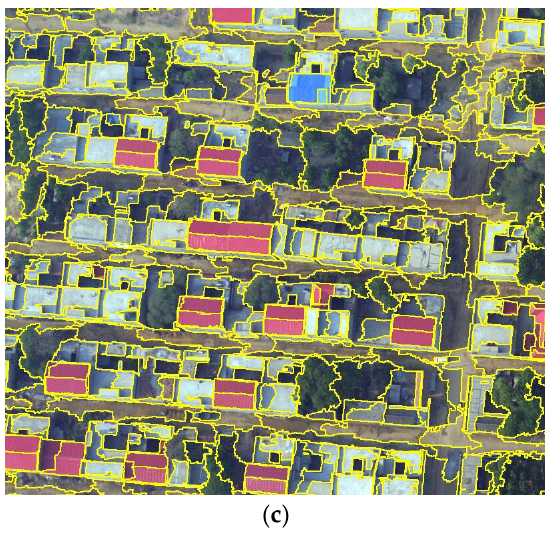
Figure 2. Results of segmented images (( a ) GF-2 satellite data, ( b ) BJ-2 satellite data, and ( c ) UAV data).